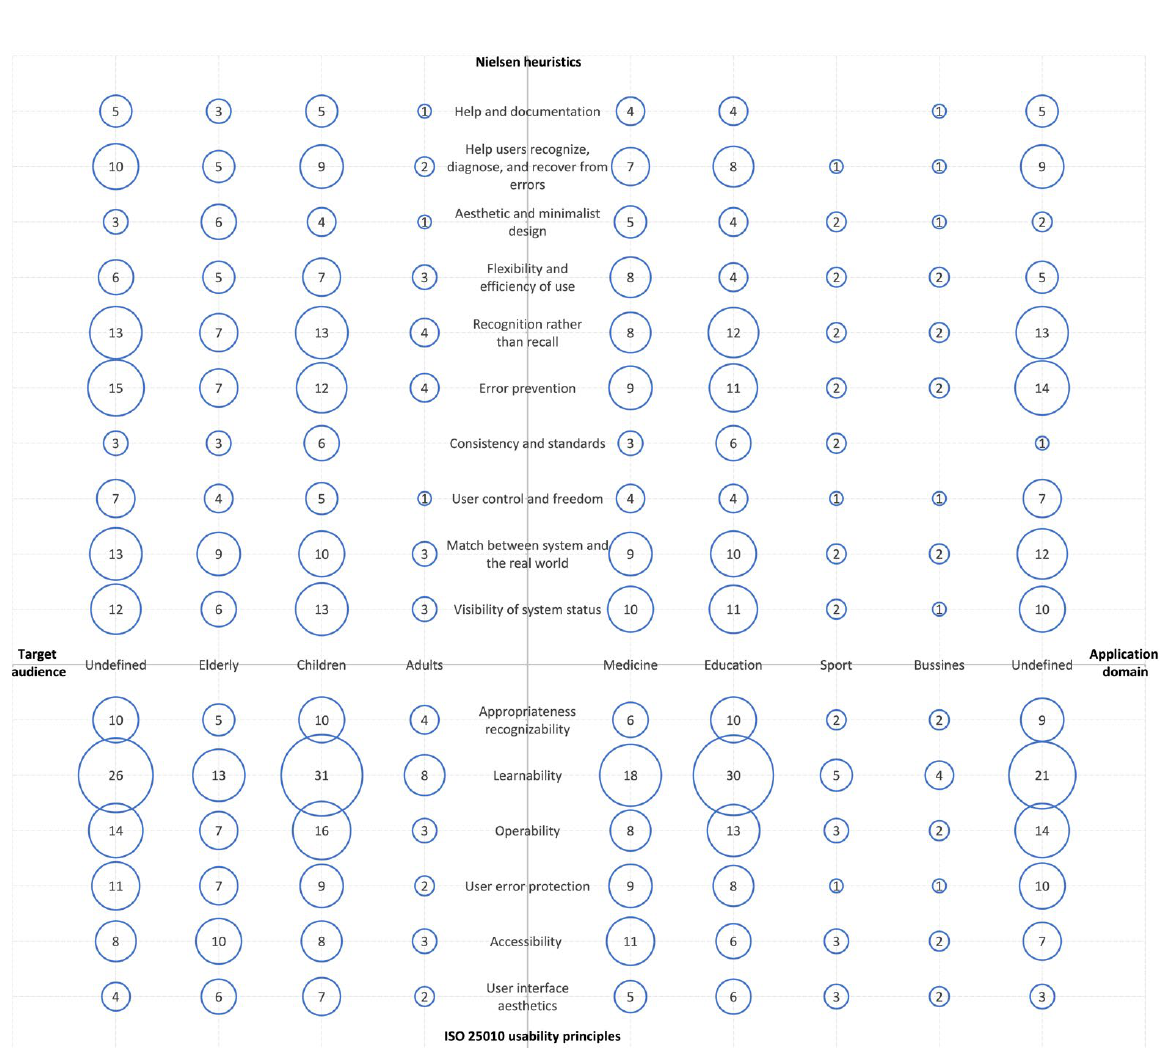
Figure 7. The number of recommendations (before merging similar ones) with respect to gamified system target audience, application domain and the nature of the recommendations provided in the publication.